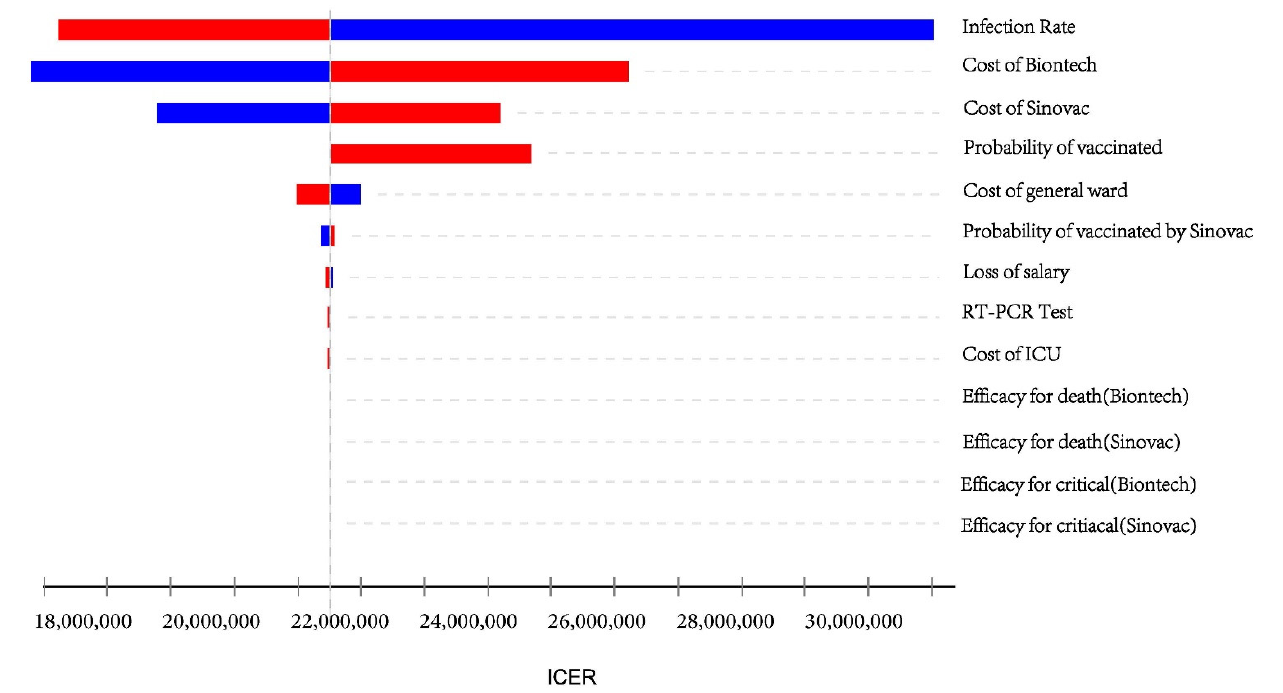
Figure 2. Tornado diagram of a one-way sensitivity analysis of parameter variabilities. The infection rate was one of the most sensitive variables affecting the cost-effectiveness of the vaccination program. When the basic infection rate increased, the ICER decreased, gradually approaching Hong Kong’s willingness-to-pay threshold. The following scenario analysis will detail this. The cost of the vaccine is another sensitive variable, with higher prices resulting in a higher ICER. Furthermore, Hong Kong supplies two types of vaccines with different coverage rates and efficiencies. A comparison of these two vaccines revealed that the BioNTech vaccine was more sensitive than the Sinovac vaccine at the same price and vaccination rate